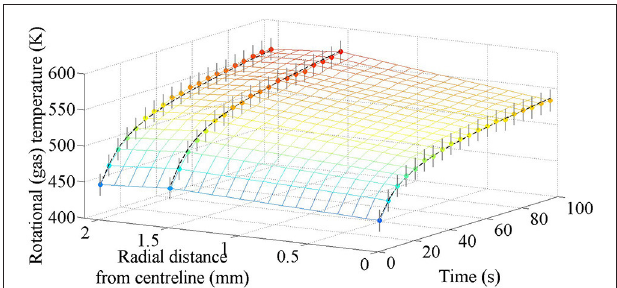
FIGURE 4 | Spatiotemporal results for rotational (hence neutral gas) temperatures for a 60 W, 1.5 Torr nitrogen discharge during the first 100 s of operation. Measured temperature results are shown as filled circles with corresponding error bars as thin black lines. Colors are indicative of temperature and an extrapolated grid connecting the measurement points is included as a visual aid. The thicker dashed black lines represent the fit lines shown in Equations